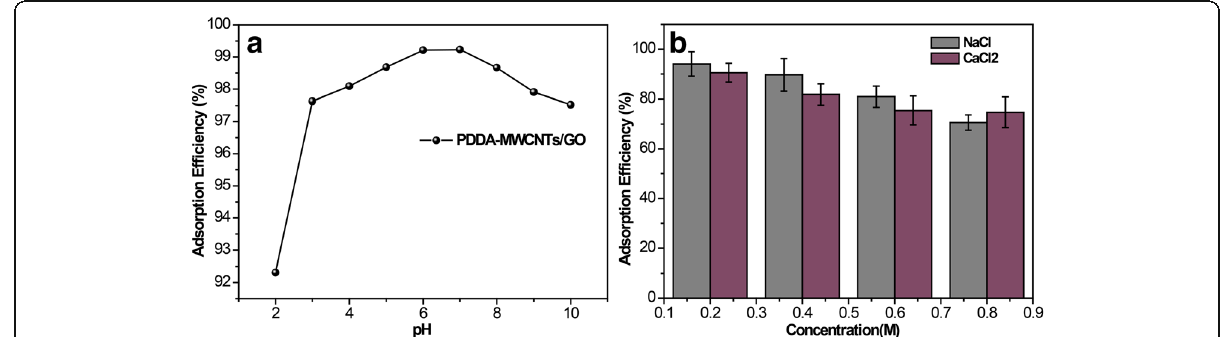
Fig. 7 a Effect of adsorption of TCH at different pH. b Effect of adsorption of TCH in saline